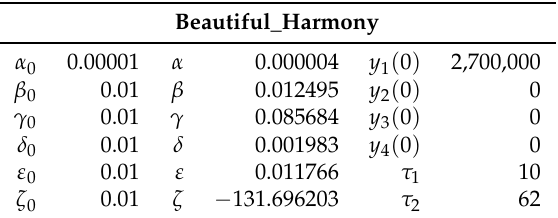
Figure 5. Fitting to “Reiwa” data. Table 5. Various parameter